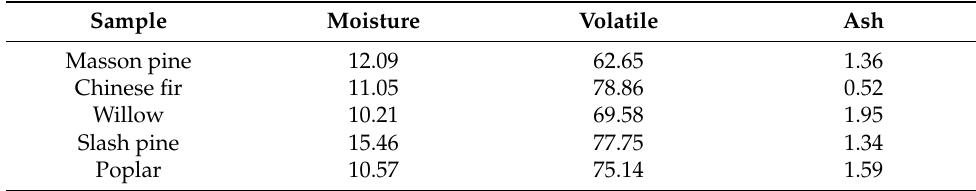
Table 1. Industry analysis of five kinds of biomass pellet fuel